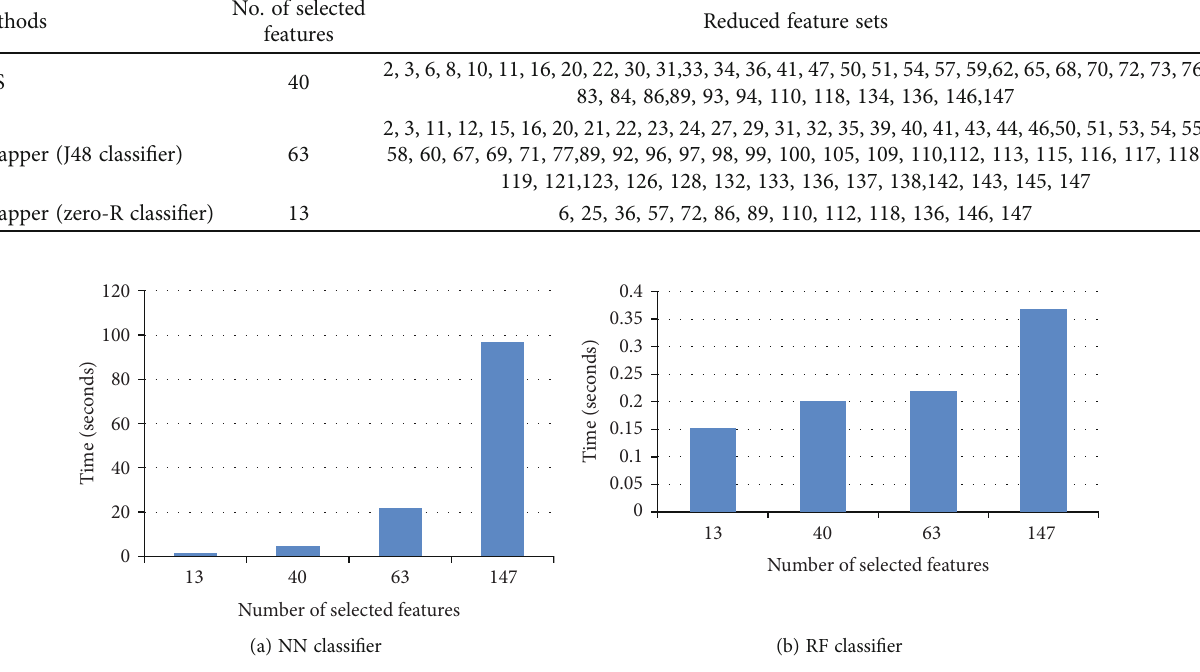
Figure 6: Time to build classi fi cation models for di ff erent number of features using NN and RF classi fi ers. Table 3: Classi fi cation accuracy for NN and RF classi fi ers and di ff erent feature sets.